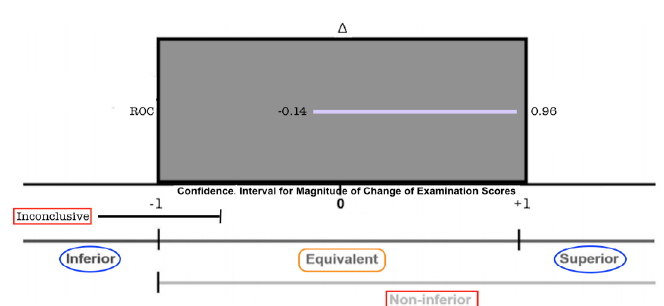
Figure 4. Analysis of magnitude of change of pre- and post- test exam scores. X- axis depicts confidence intervals (CI) of magnitude of change between pretest and post test scores falling withing the pre-set equivalence margin (Δ), ranging from -1 to 1. Y- axis depicts category of magnitude of change between pretest and post test scores of the entire cohort. Boxed term in orange indicates margins of Statistical Equivalence (representing the study’s primary outcome measure). Boxed terms in red represent graph legend of possible statistical data outcomes including Non-inferiority and Inconclusive. Boxed terms in blue represent graph legend of possible statistical data outcomes including superiority and